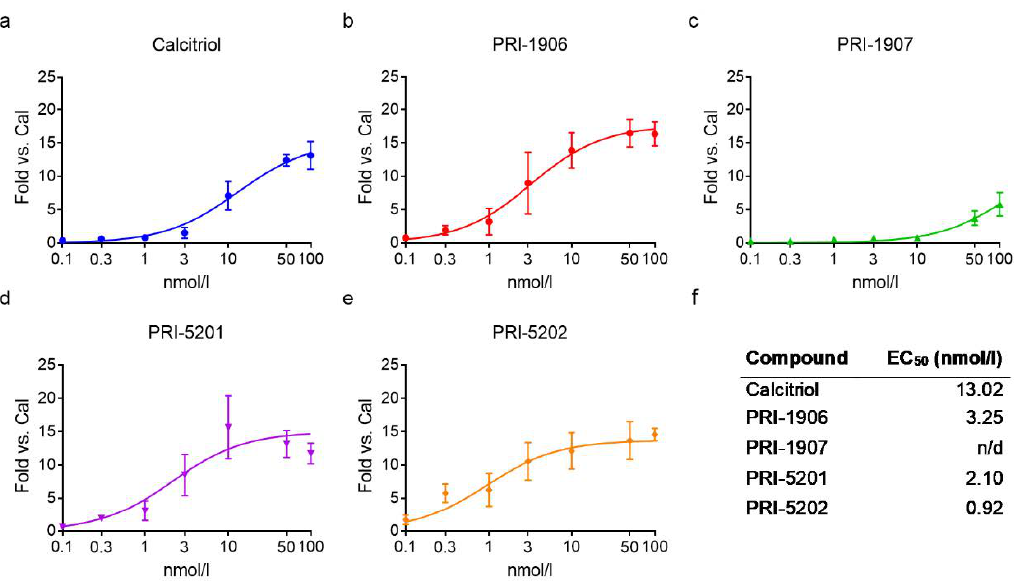
Figure 4. Activity of the compounds in the 14433 cell line. ( a – e ) Concentration-response curves for CYP24A1 expression after treatment with the an1,25Ds for 4 h. Mean ± SD, nonlinear regression: sigmoidal three parameter fit with the following constraints: bottom > 0, EC 50 > 0; N = 3–12. ( f ) The table shows the calculated EC 50 values (n/d = not determined).